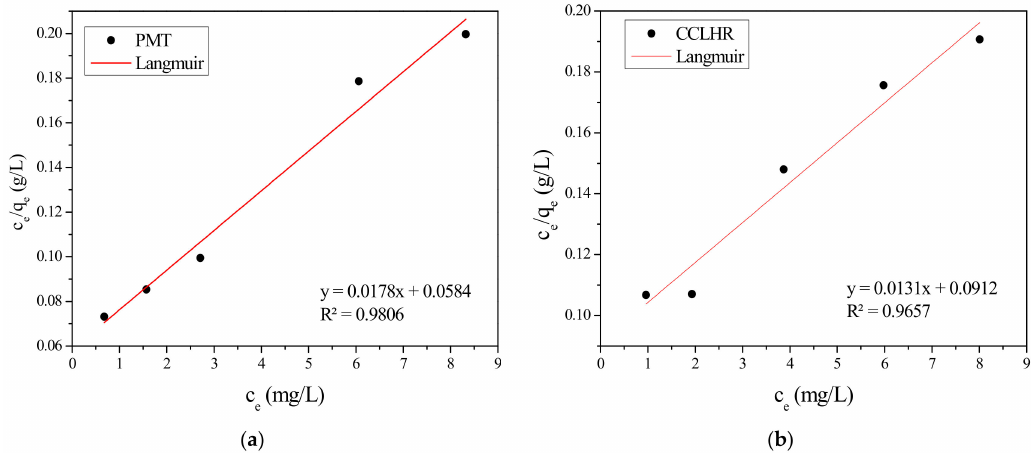
Figure 6. Freundlich isothermal adsorption equation fitting of methylene blue: ( a ) PMT, ( b ) CCLHR.